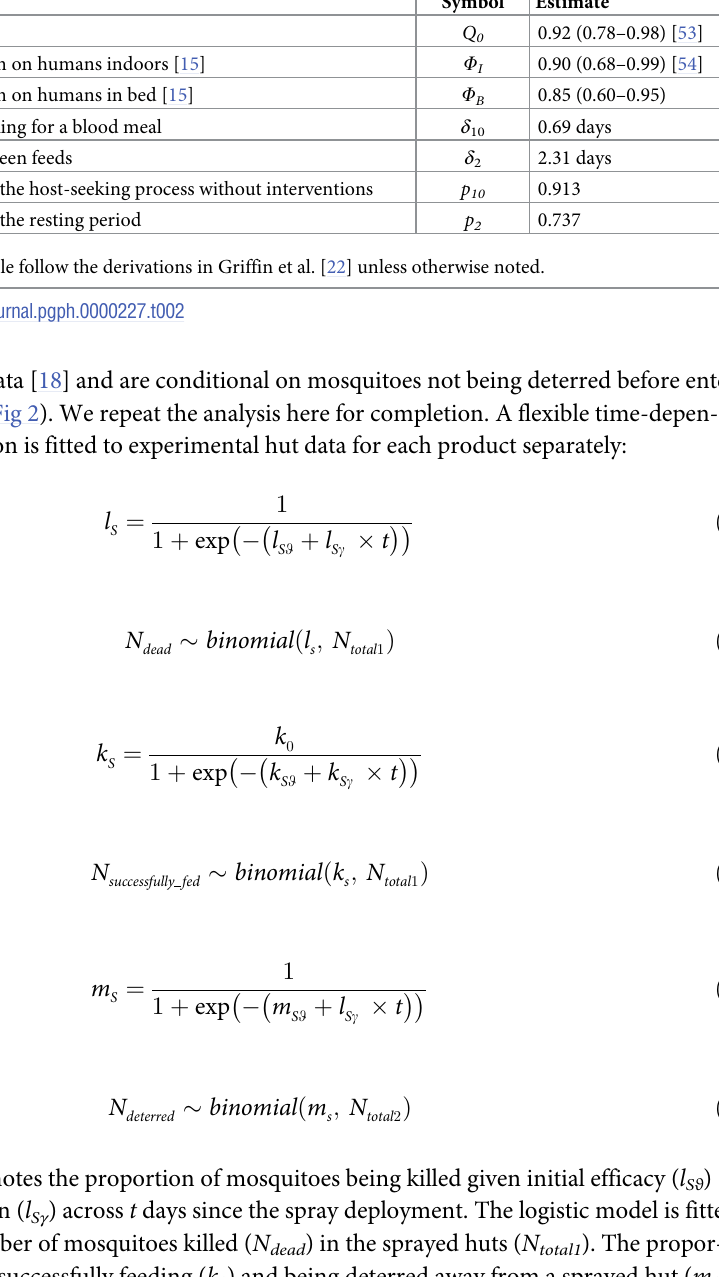
Table 2. Mechanistic model parameters for the estimation of mosquito bites per day. Parameter estimates repre- sent a generic “An. funestus-like” mosquito.